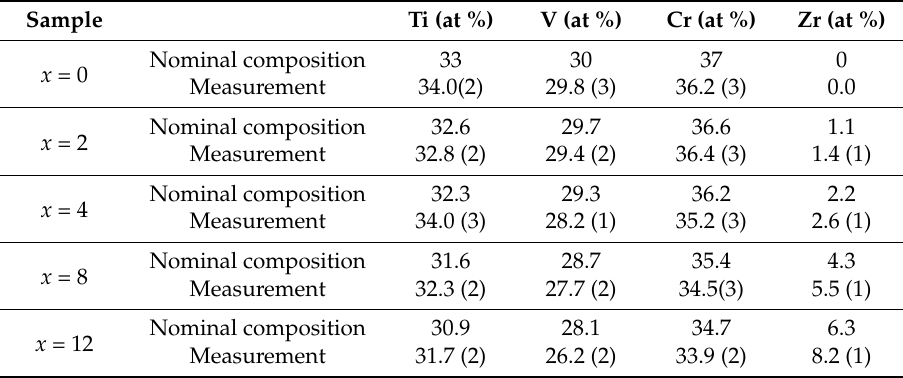
Table 1. Bulk atomic abundance: nominal and as measured by EDX of: Ti 1 V 0.9 Cr 1.1 + x wt % Zr alloys for x = 0, 2, 4, 8, and 12. Error on the last significant digit is indicated in parentheses.